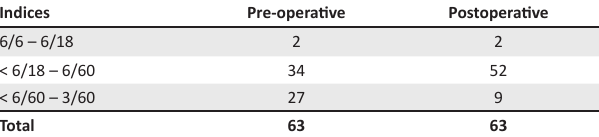
TABLE 3: Pre-operative and postoperative visual acuity of 63 eyes.